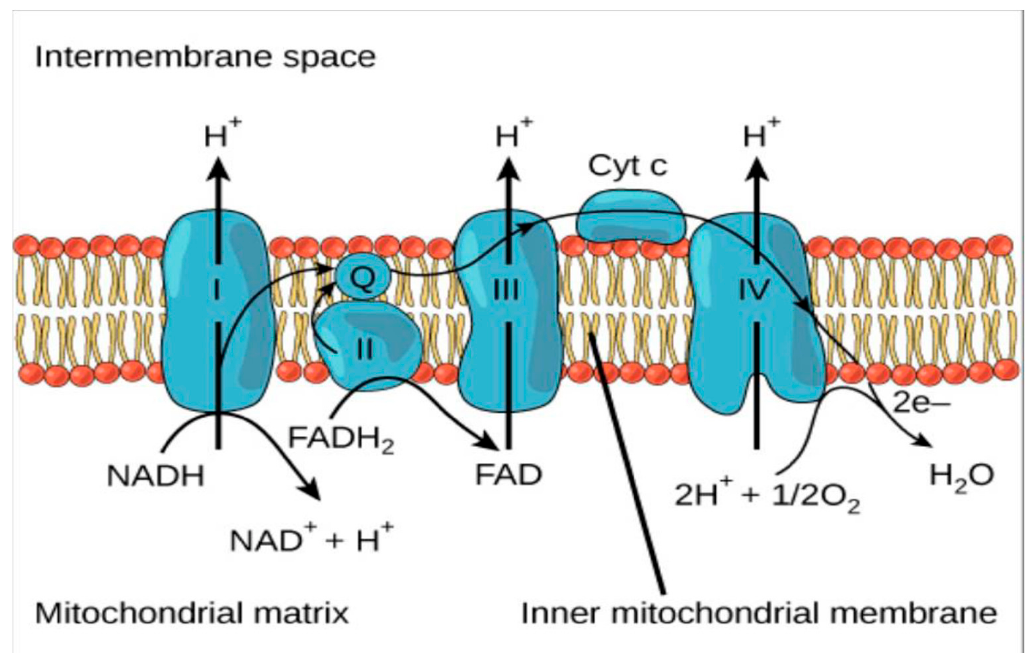
Figure 1. The electron transport chain is a series of electron transporters embedded in the inner mitochondrial membrane that shuttles electrons from NADH and FADH 2 to molecular oxygen. In the process, protons are pumped from the mitochondrial matrix to the intermembrane space, and oxygen is reduced to form water (Source: Electron Transport Chain [50]).